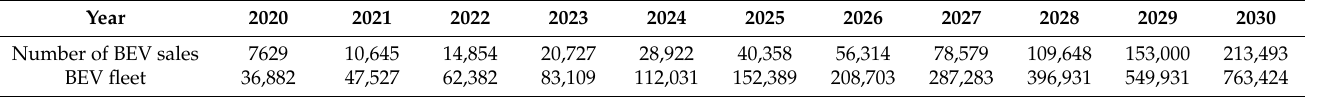
Table 6. Impacts of the BEV fleet on the grid during peak hours under scenario 1 (values in kVA).